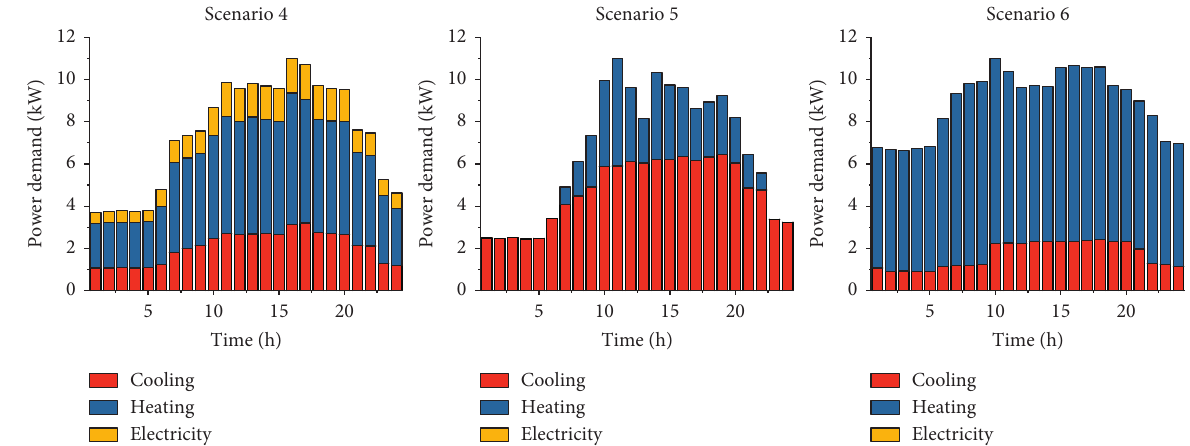
Figure 9: System energy supply information of scenarios 4–6 (designed for winter load). Table 6: Optimisation results summary